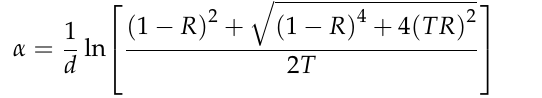
where d is the film’s thickness. The films are suited for use as an absorber layer in solar cells due to their high absorption (10 5 cm − 1 ) properties.